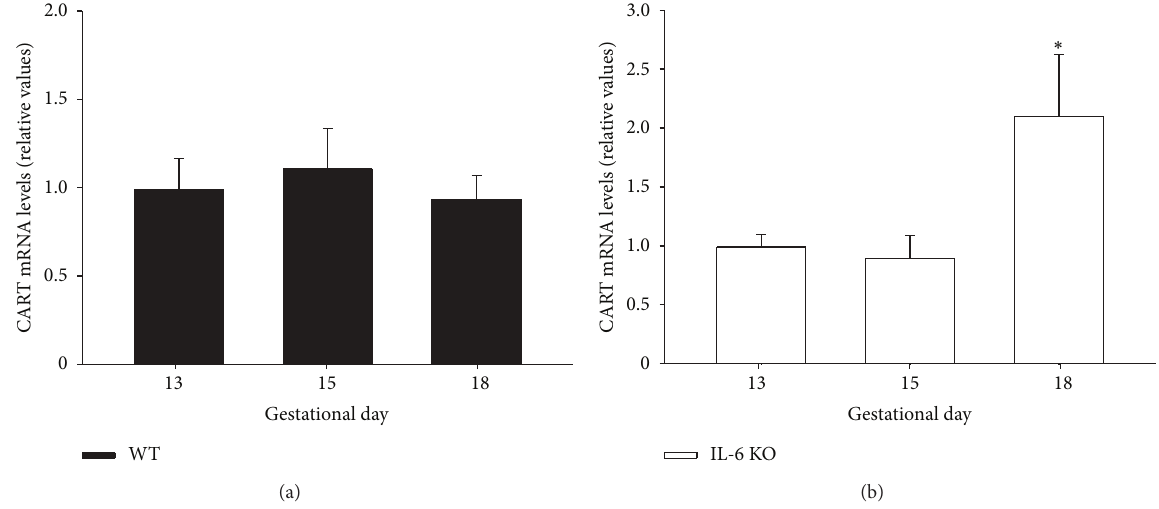
Figure 6: CART mRNA expression in placenta of WT and IL-6 KO mice. 12-week-old WT and IL-6 KO mice were time-pregnant and placental CART mRNA levels in (a) WT and (b) IL-6 KO mice at different pregnancy stages (13,15, and 18 days) were assessed by real-time qPCR; 𝑛 = 5 - 6 . Within each genotype, relative mRNA levels were normalized to 13 days pregnant mice values as 1. Each value represents the mean ± SEM. One-way ANOVA: ∗ 𝑃 < 0.05 versus 13 days pregnant mice of respective